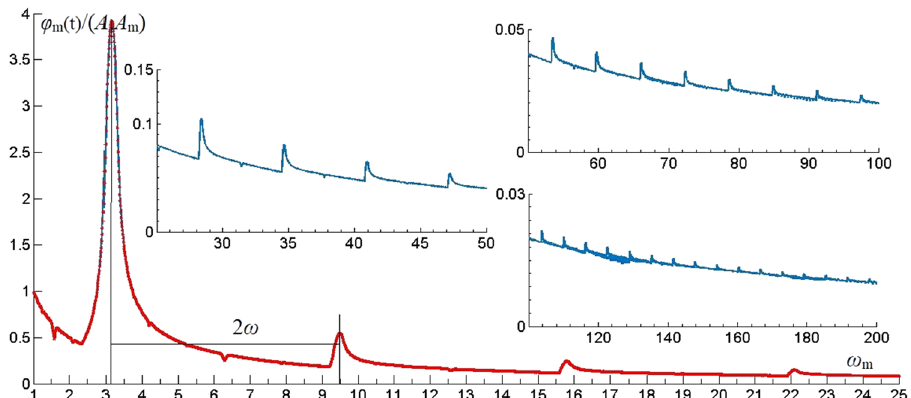
Figure 3. The vibration of φ m (t) of ω m under triangular wave.